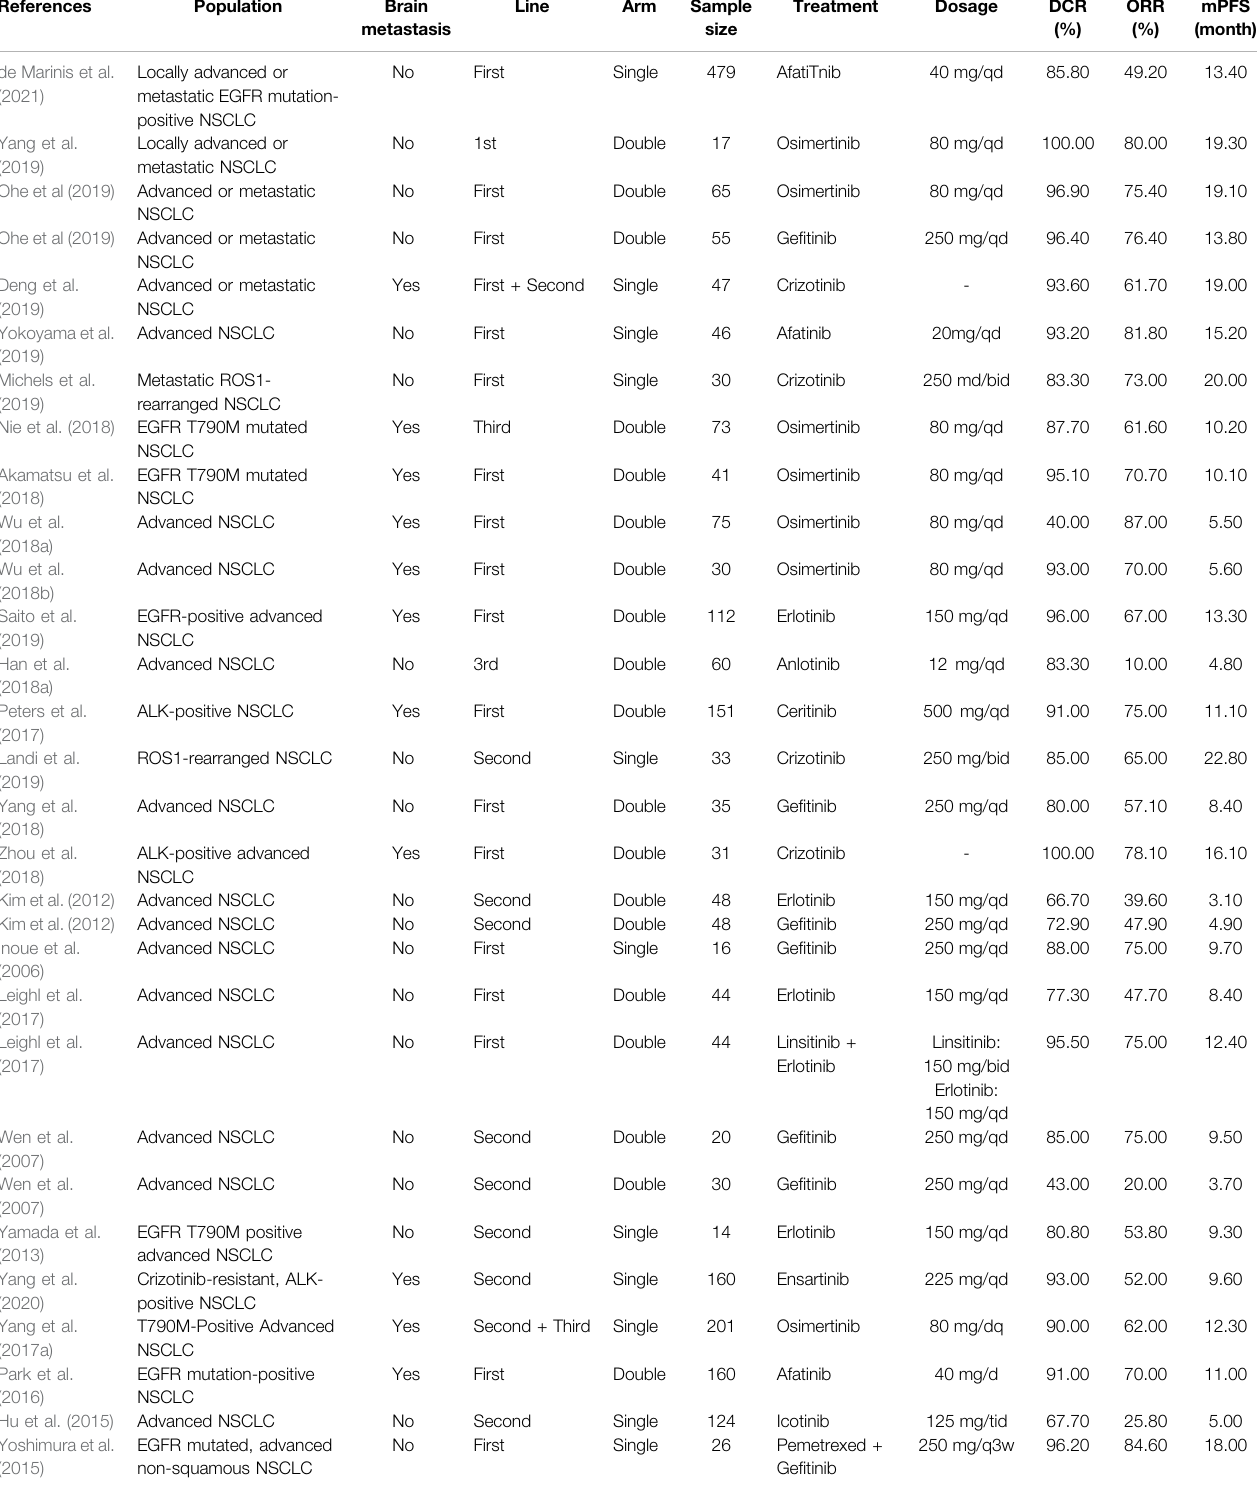
TABLE 2 | Overview of general characteristics of studies reporting ORR, DCR, and